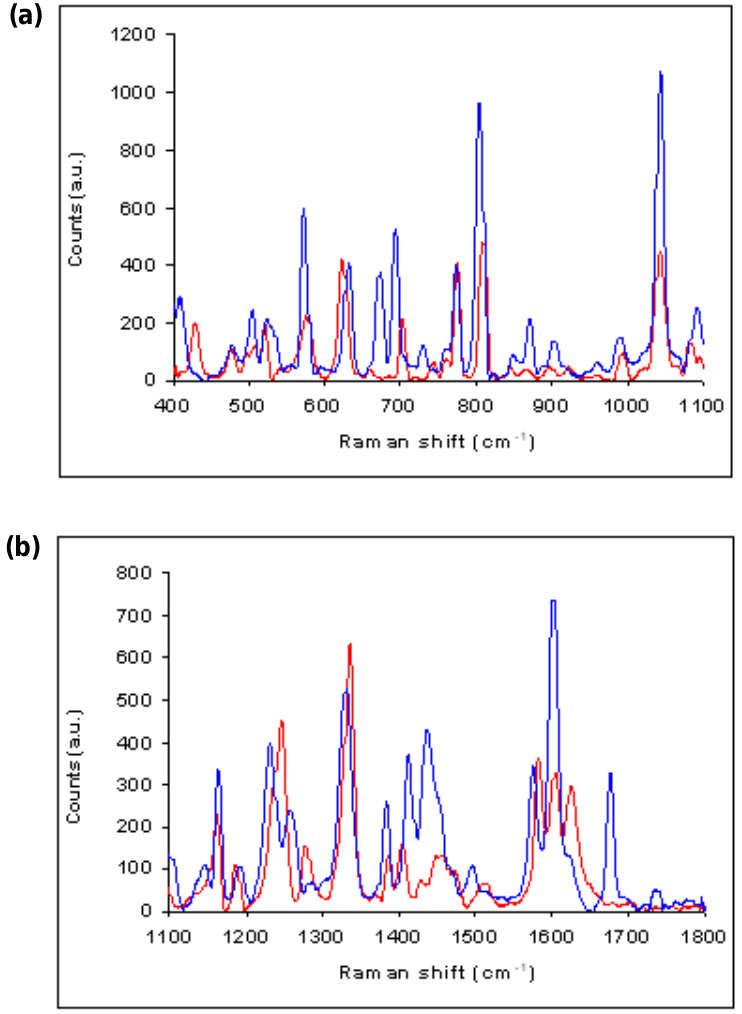
Figure 5. In-situ Raman spectra from ( a ) 400–1100 cm –1 and ( b ) 1100–1800 cm –1 showing Form I in red crystallized from a 90 mg/mL DMF microemulsion compared to Form II in blue crystallized from a 120 mg/mL DMF